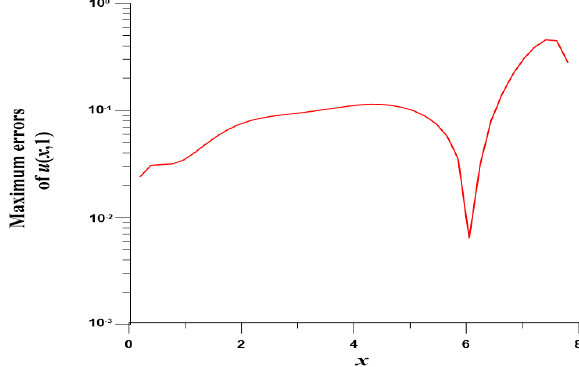
𝑡𝑡 𝑓𝑓 = 1. 𝑡𝑡 𝑓𝑓 = 1. 𝑡𝑡 𝑓𝑓 = 1.